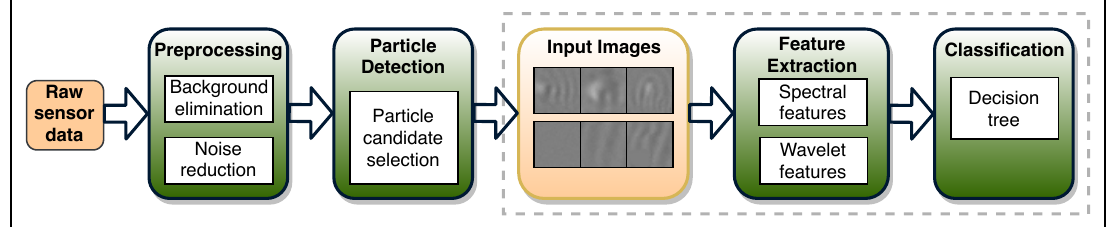
Figure 3. The image processing